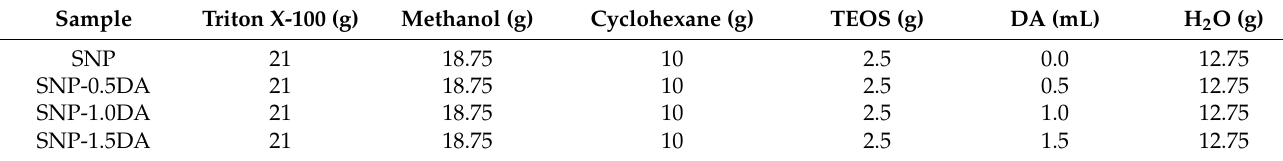
Table 1. Synthesis compositions for the prepared